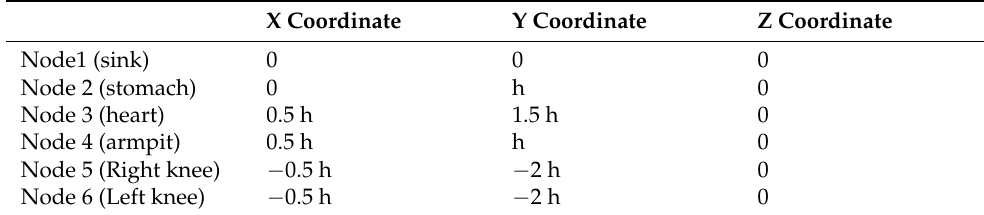
Table 4. Node position when the human was static.